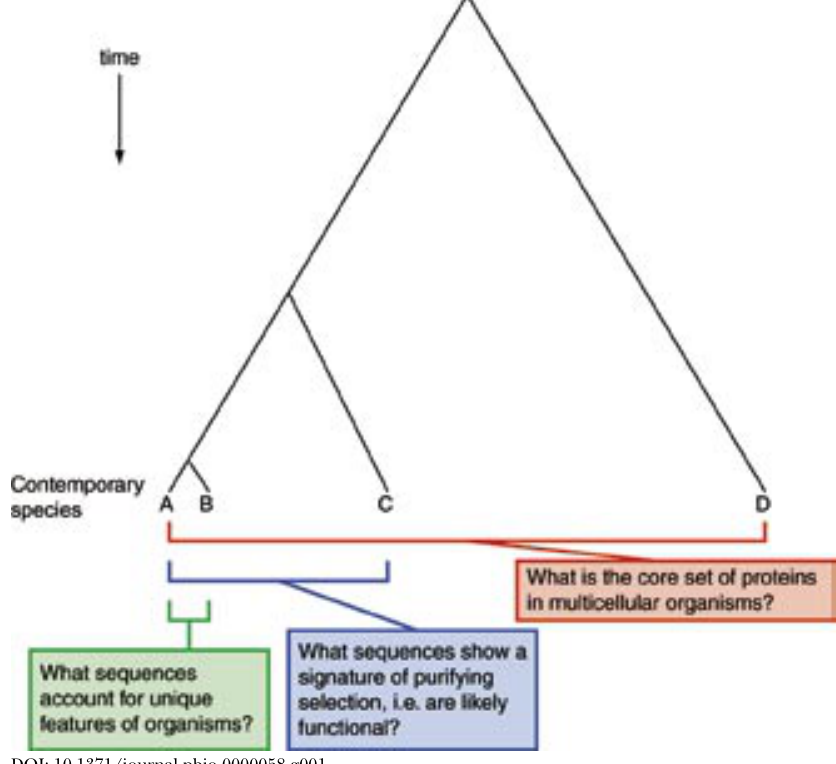
Figure 1. Comparisons of Genomes at Different Phylogenetic Distances Are Appropriate to Address Different Questions A generalized phylogenetic tree is shown, leading to four different organisms, with A and D the most distantly related pairs. Examples of the types of questions that can be addressed by comparisons between genomes at the different distances are given in the